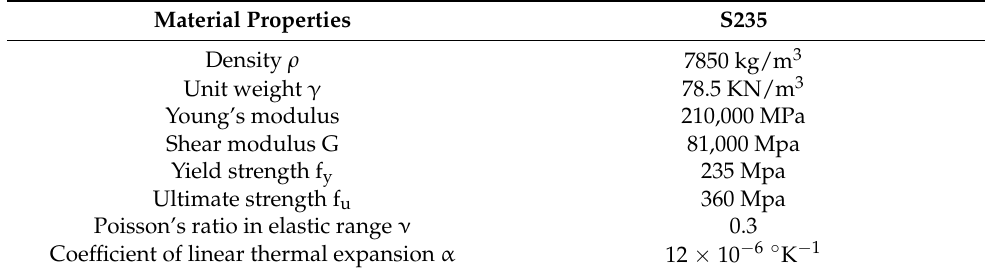
Table 4. Material properties of S235.